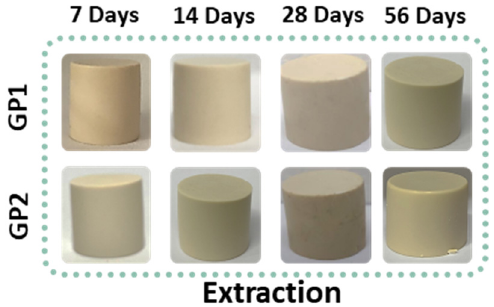
Figure 4 . GP1 and GP2 samples extracted at 7, 14, 28, and 56 days. Figure 4. GP1 and GP2 samples extracted at 7, 14, 28, and 56